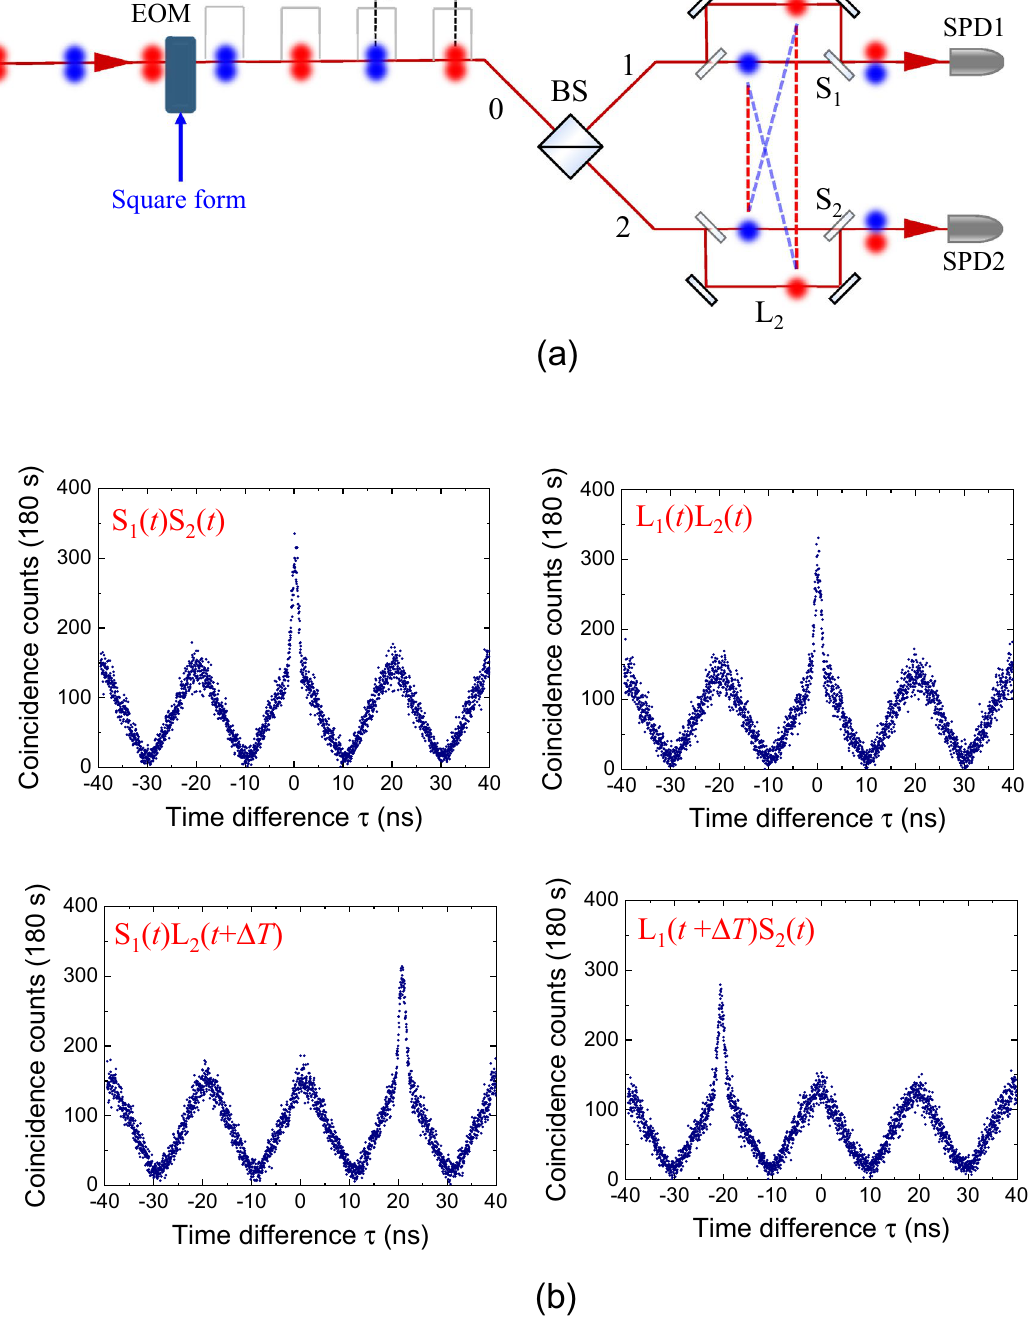
Figure 3. Square-modulated thermal photons with period of Δ T . ( a ) Experimental schematic for measurement of the second-order self-correlation functions of the square-modulated thermal photons with period of 20 ns. ( b ) Coincidence events in four cases of short-short (S 1 S 2 ), long-long (L 1 L 2 ), long-short (L 1 S 2 ), and short-long (S 1 L 2 )